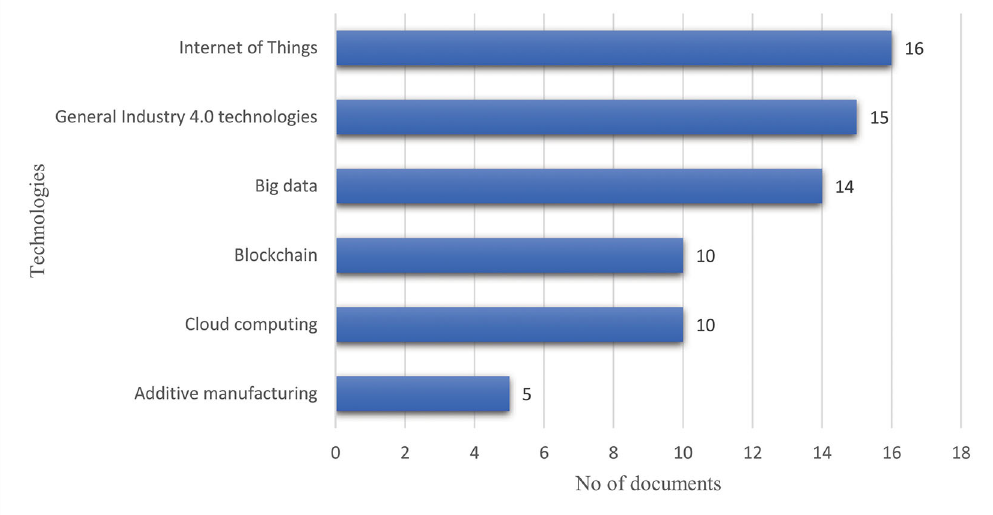
Figure 12. Frequency of the emerging technologies identified in the reviewed